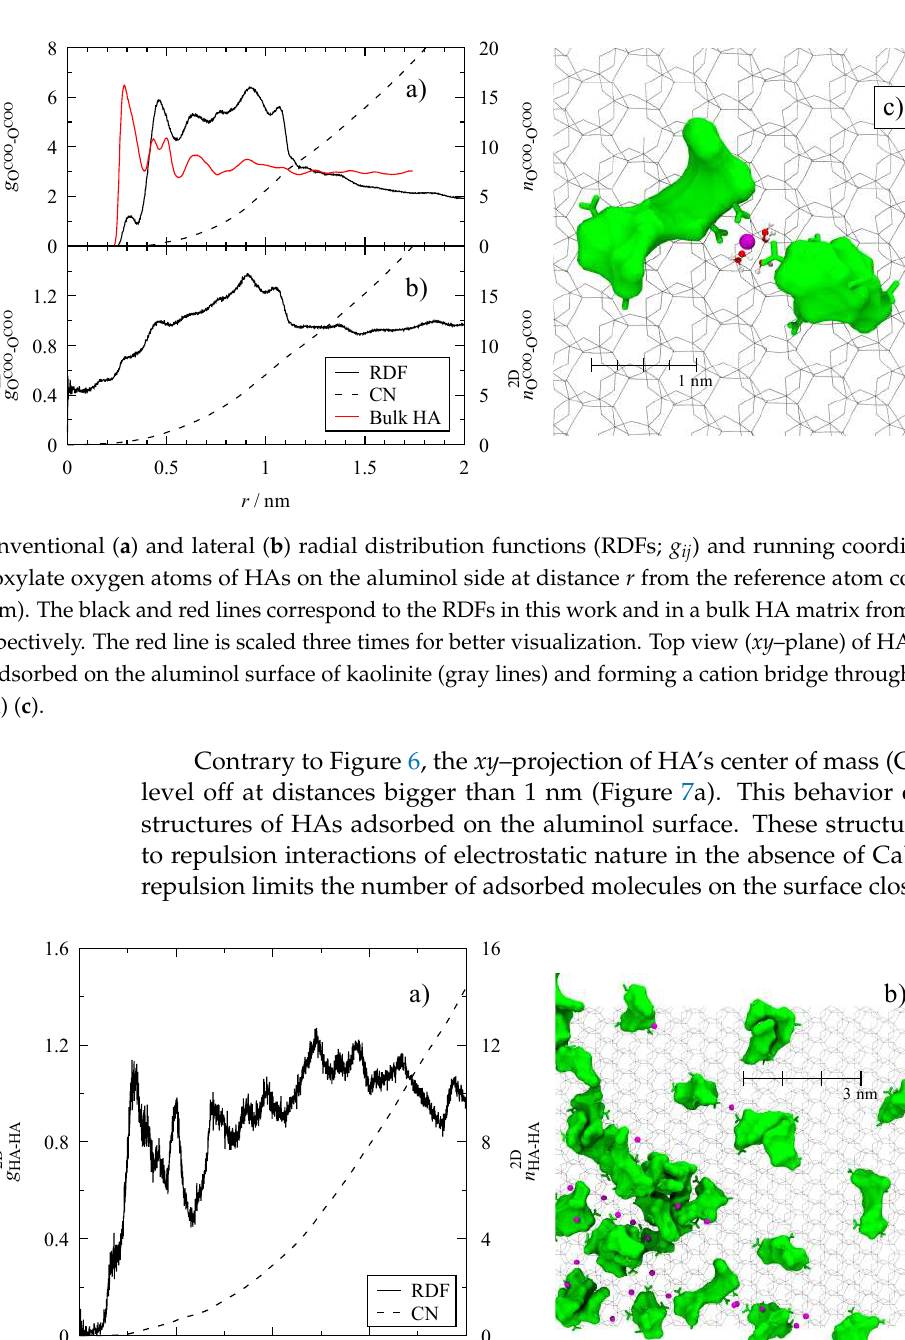
Figure 8. Lateral radial distribution function (RDF; g ij ) and integrated coordination number (CN) of Ca 2+ cations on the siloxane side at distance r confined in 0 < z < 0.6 nm space ( a ). Top view ( xy –plane) of Ca 2+ cations (magenta balls) adsorbed on the siloxane surface of kaolinite (gray lines) ( b ). 4. Discussion 4.1. Influence of Kaolinite on HA Aggregates Newer concepts regarding the understanding of soil nature, such as the soil contin- uum model (SCM), consider the formation of supramolecular structures mimicking large molecules [2,58]. This makes the selection of LHA aggregates as representatives of SOMs consistent with long–standing concepts and new insights into soil. Similarly, it was shown that stable supramolecular structures break into fragments when interacting with reactive surfaces in a reversible process [40,41]. This allows the organic matter to stabilize and/or